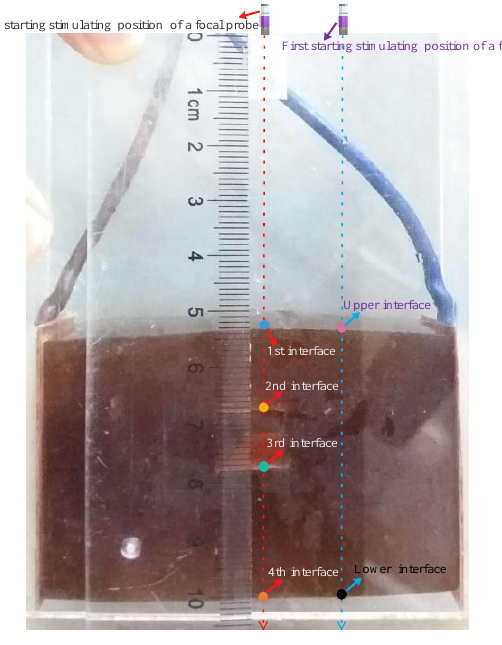
Figure 9. The stimulating positions of two experiments.